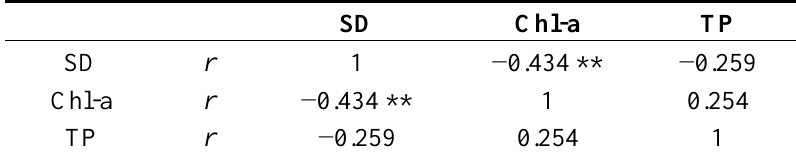
Table 2. Correlation analysis matrix of measured parameters of Tain-Pu reservoir during the measurement, in situ , from May 2002 to May 2013.